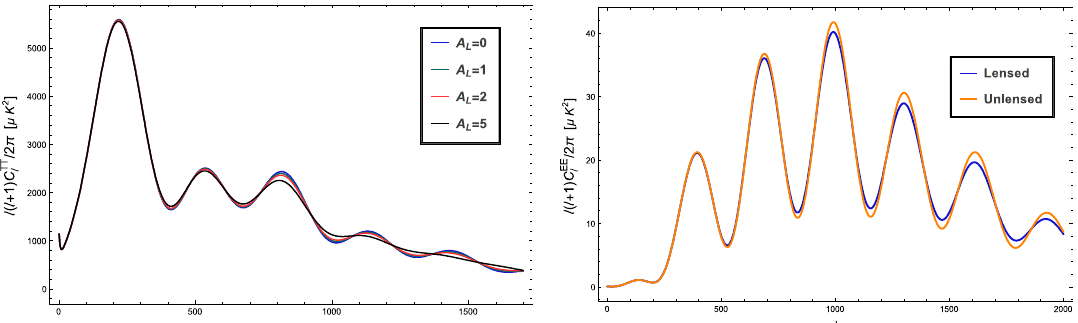
Figure 24. Gravitational Lensing Smears CMB power spectrum peaks both temperature (left panel, for di ff erent lensing amplitudes) and E-mode polarization (right panel): Again gravitational lensing from intervening matter (purple) causes varying across the map slight magnification variation in the primeval pattern e ff ectively averaging over several maps and thus smoothing down the peaks. Magnification is equivalent to stretching the power spectrum. (Credit Alejandro